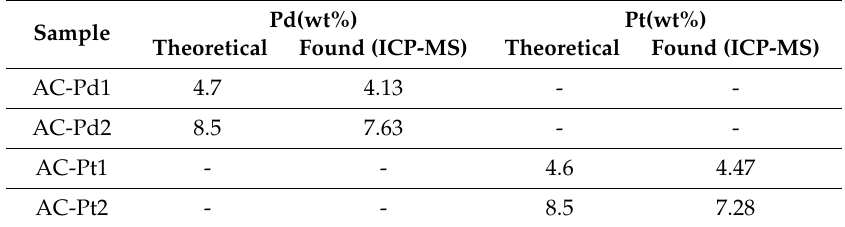
Table 2. Composition of the Pd/AC and Pt/AC composites.